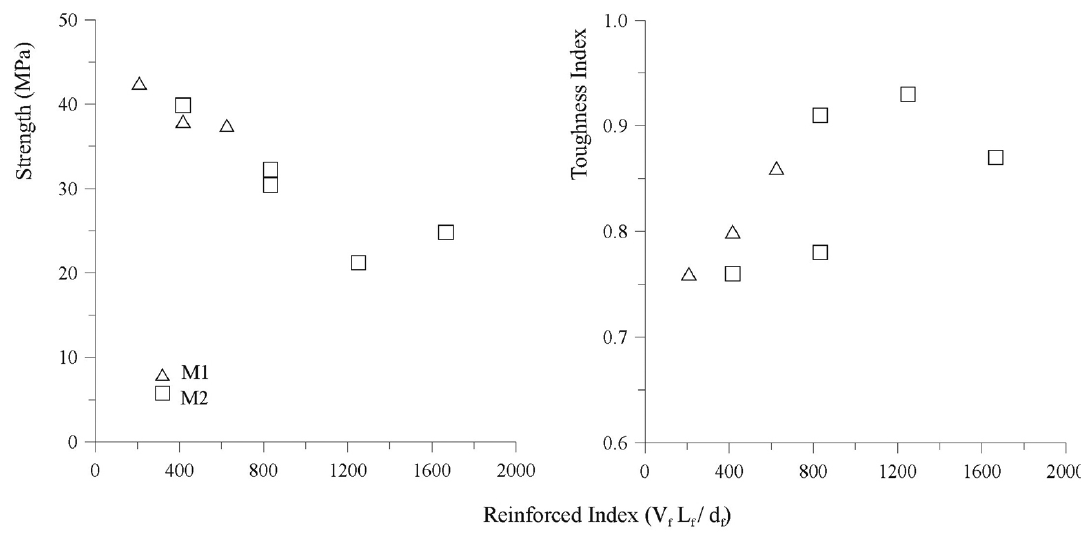
Figure 7. Influence of the reinforcement index on the toughness index and compressive strength of the